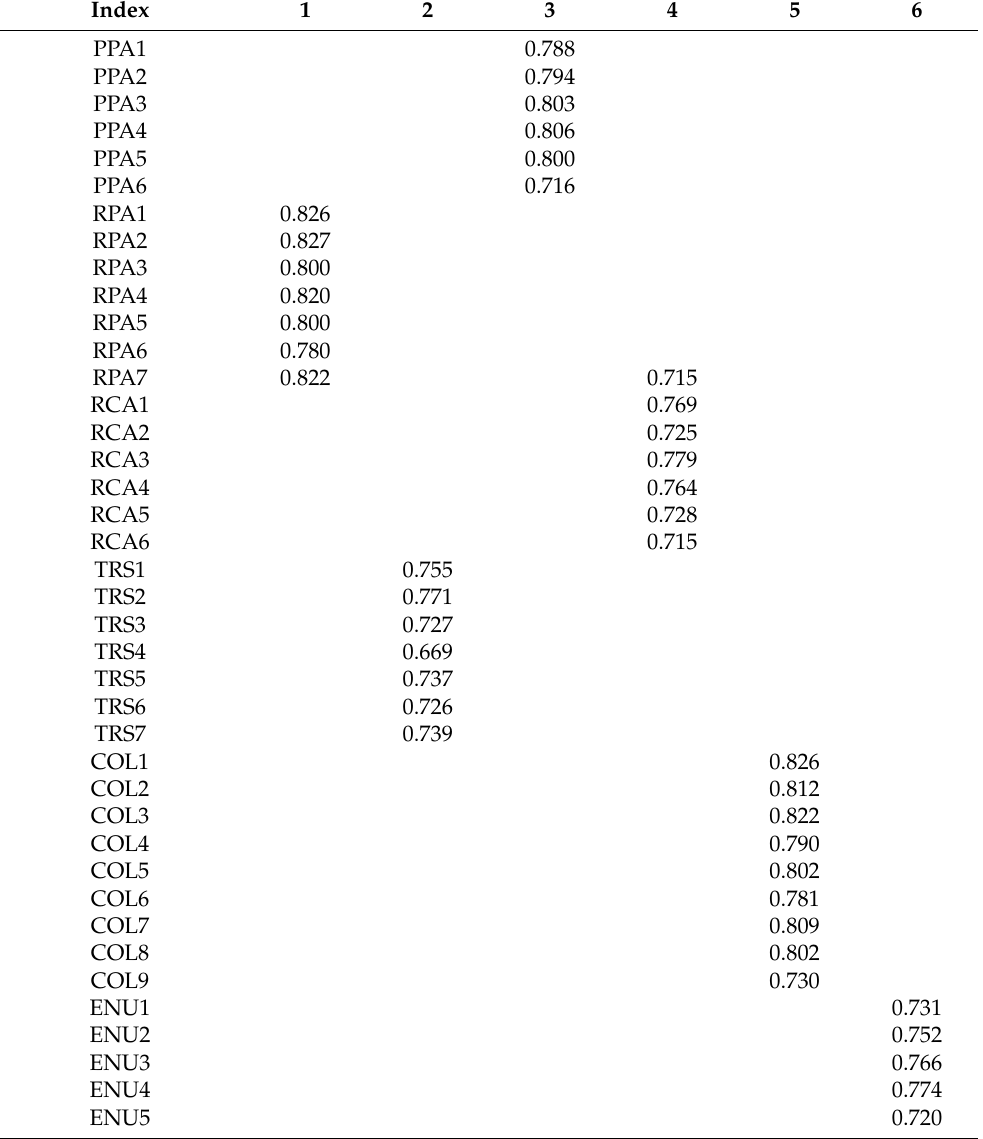
Table 4. Rotating component